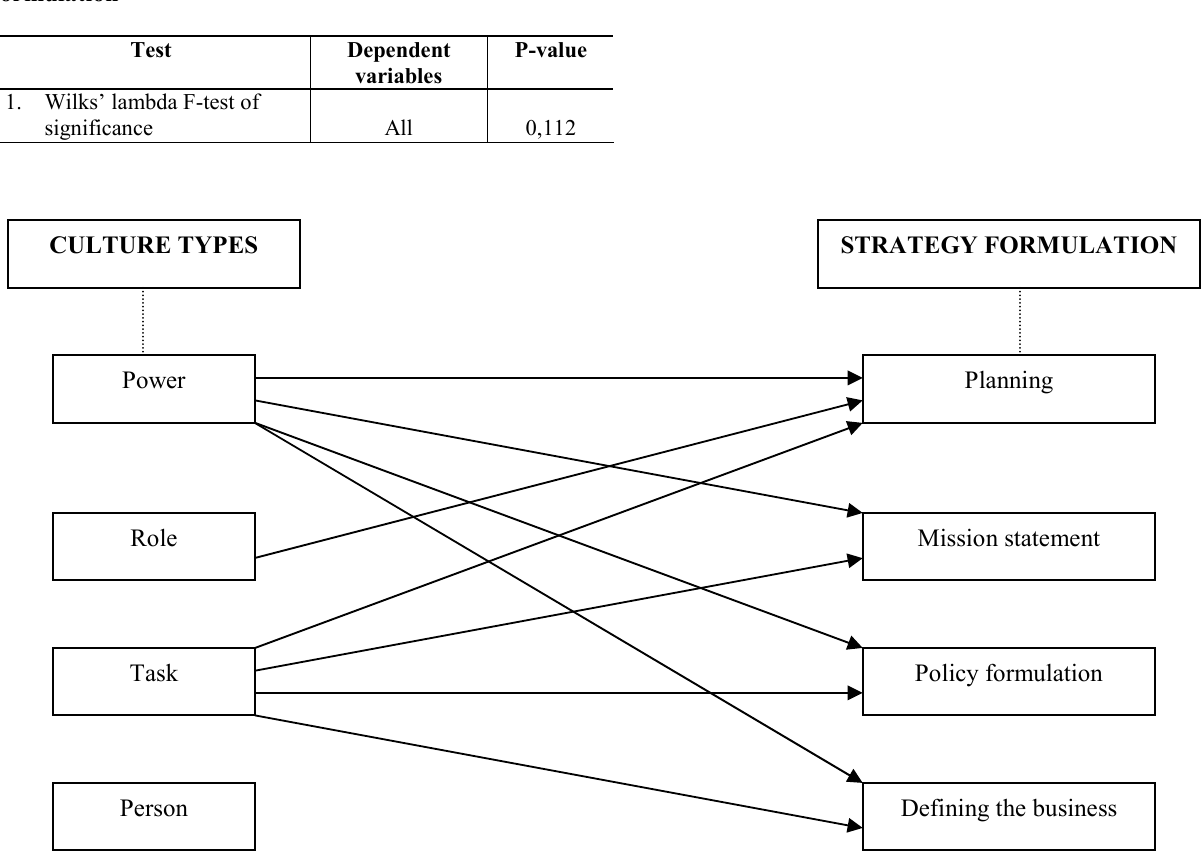
Figure 3: The relationship between culture type variables and strategy formulation